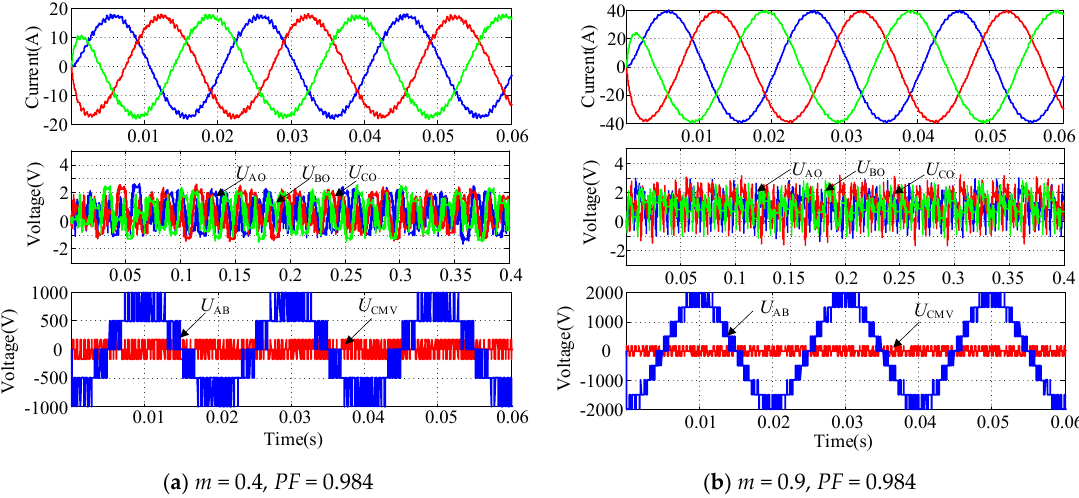
Figure 8. The simulation waveforms under the algorithm. ( a ) The three-phase current, midpoint potentials, line voltage between phase A and phase B, and common-mode voltage when m is 0.4; and ( b ) The three-phase current, midpoint potentials, line voltage between phase A and phase B, and common-mode voltage when m is